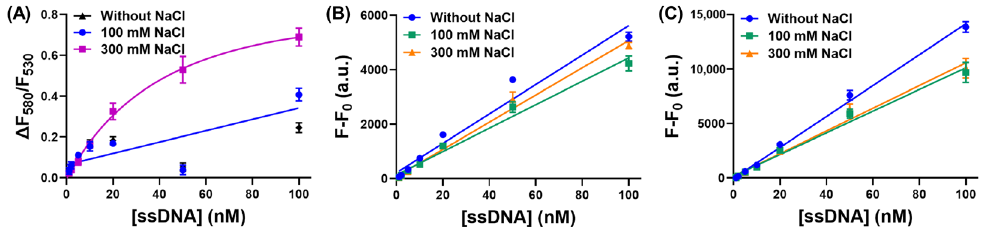
Figure 2. ( A ) The fluorescence ratio changes of PMNT in response to ssDNA concentration in the presence of 0–300 mM NaCl. The concentration of PMNT was 5 μM. The fluorescence intensity changes of SGI ( B ) and SYBR Gold ( C ) in response to ssDNA concentration in the presence of 0–300 mM NaCl. The concentration of SGI and SYBR Gold was 0.5×.